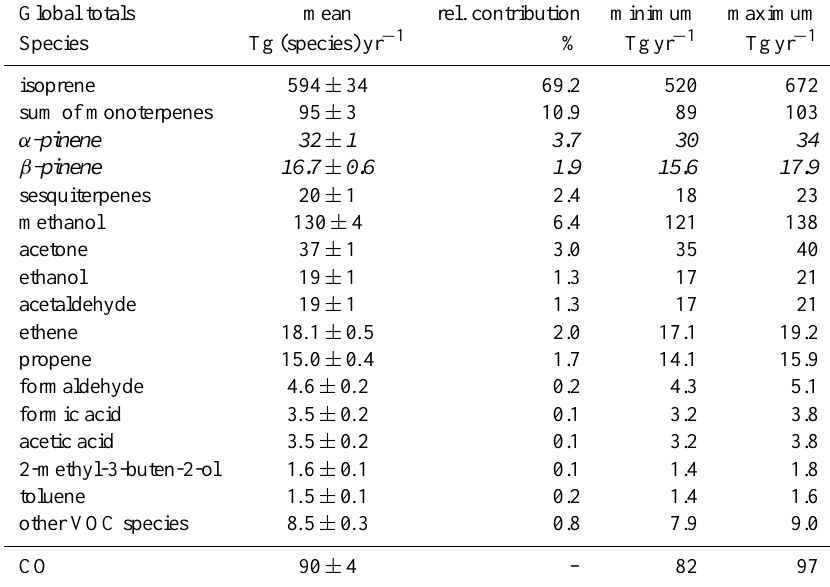
Table 1. Annual global total averaged over the period of 1980–2010 for selected BVOC species (with standard deviation σ ), their relative contribution to the global total of all BVOCs expressed as emission of carbon, maximal and minimal value within the modelled period. Note that the sum of monoterpenes already includes emissions of α -pinene and β -pinene (in italics).